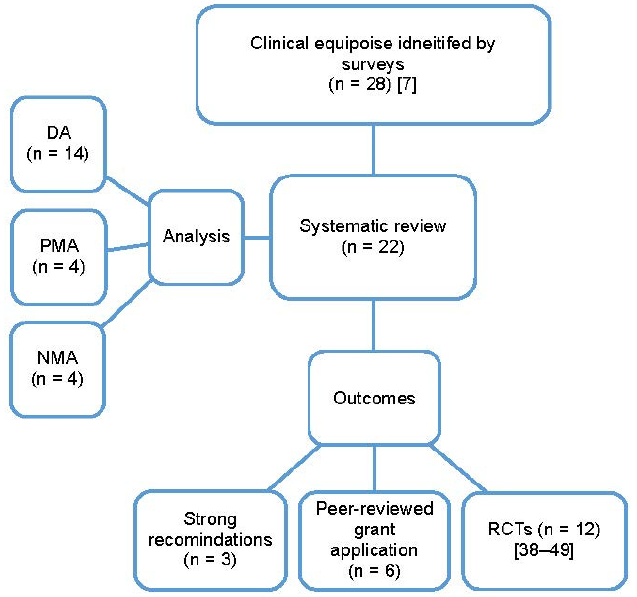
Figure 3. The type of analysis and outcomes of the systematic reviews performed and published based on clinical equipoise identified by surveys; DA, descriptive analysis; NMA, network meta ‐ analysis; PMA, pairwise meta ‐ analysis; RCTs, randomized clinical trials.